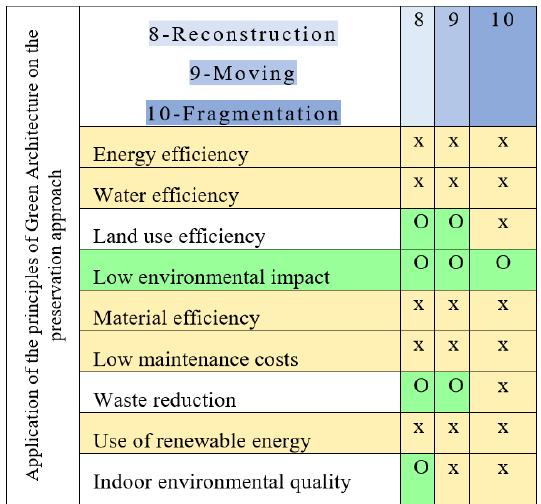
Table 1. Application of the principles of Green Architecture on the preservation approach: Preservation and Stabilization.